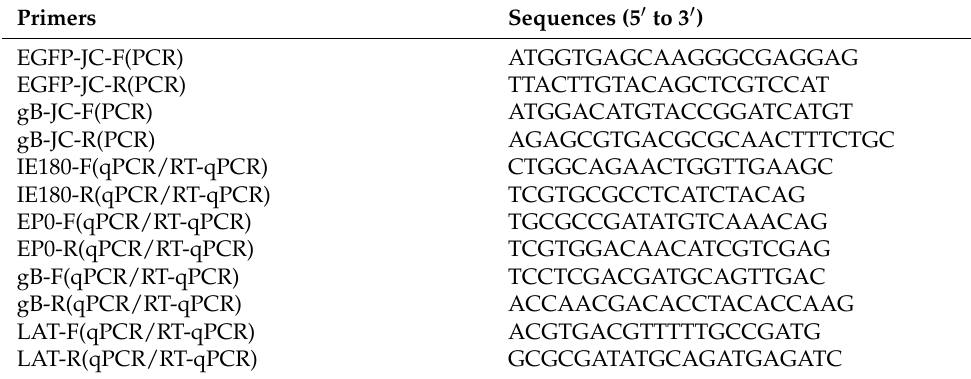
Table 2. Primers for PCR, qPCR, and